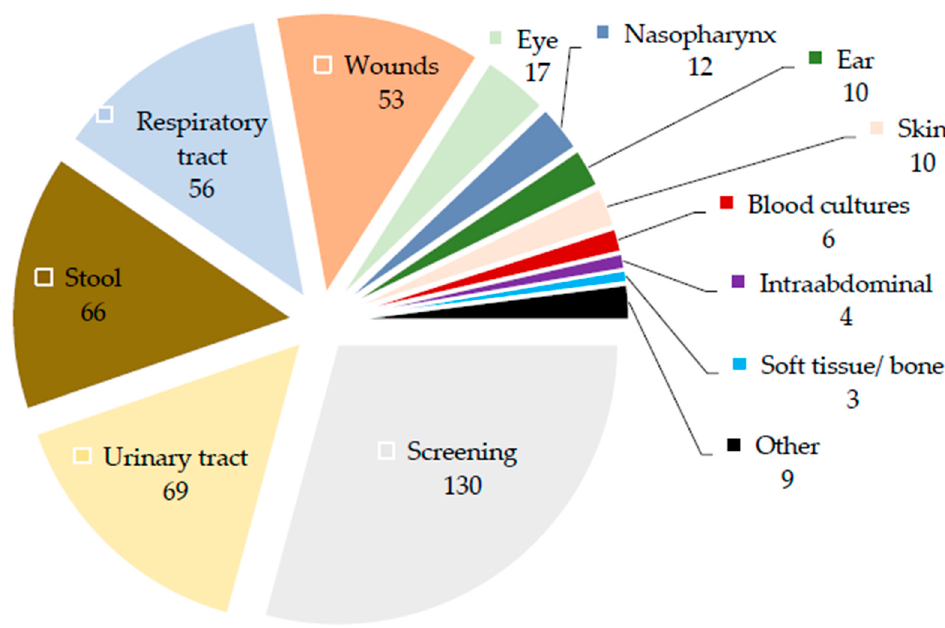
Figure 2. Number of Achromobacter isolates detected in the different specimen types.